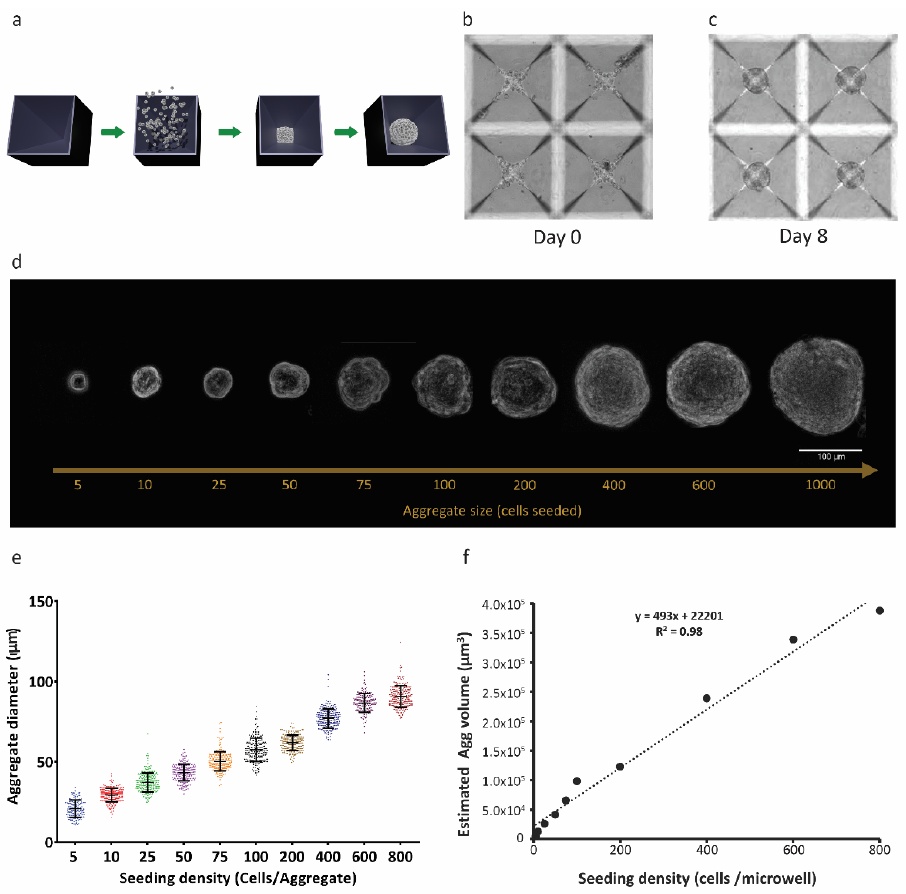
Figure 1. Three-dimensional RPE- µ Ts show consistent size control. ( a ) ARPE-19 cell suspensions were centrifuged into 400 µ m microwells and cultured to produce RPE- µ T. ( b ) Cells settled at the bottom of the microwells and ( c ) formed robust spherical RPE- µ Ts by 8 days in culture. The size of the 3D RPE- µ Ts correlated with the number of cells seeded per microwell, as evidenced either visually ( d ) or via quantitative analysis ( e ). Each group of seeded cells per RPE- µ T was significantly different from all others based on a one-way ANOVA followed by Tukey’s post hoc test (n = 100, p < 0.001). ( f ) Approximating RPE- µ Ts as spheres with the observed diameters, we observed that their calculated volume showed a strong linear correlation with the number of cells from which they were formed (R 2 =